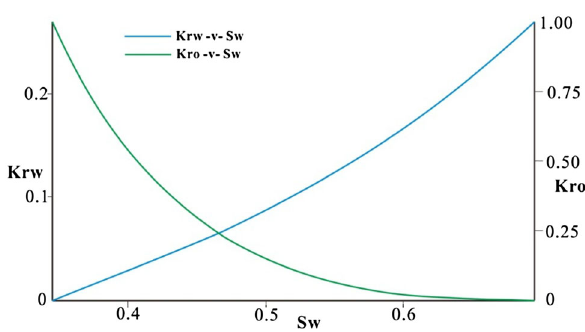
Fig. 12 The relative permeability curve selected in the